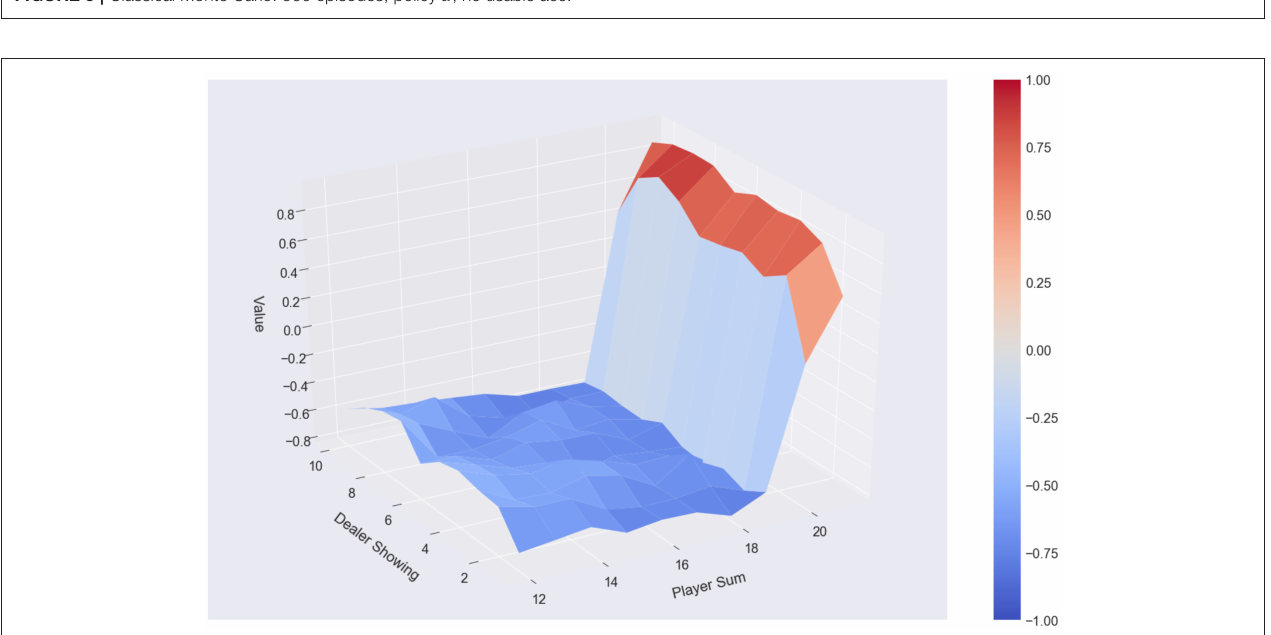
FIGURE 6 | Classical Monte Carlo: 500 episodes, 7 policies, policy α , averaging over results, no usable ace.